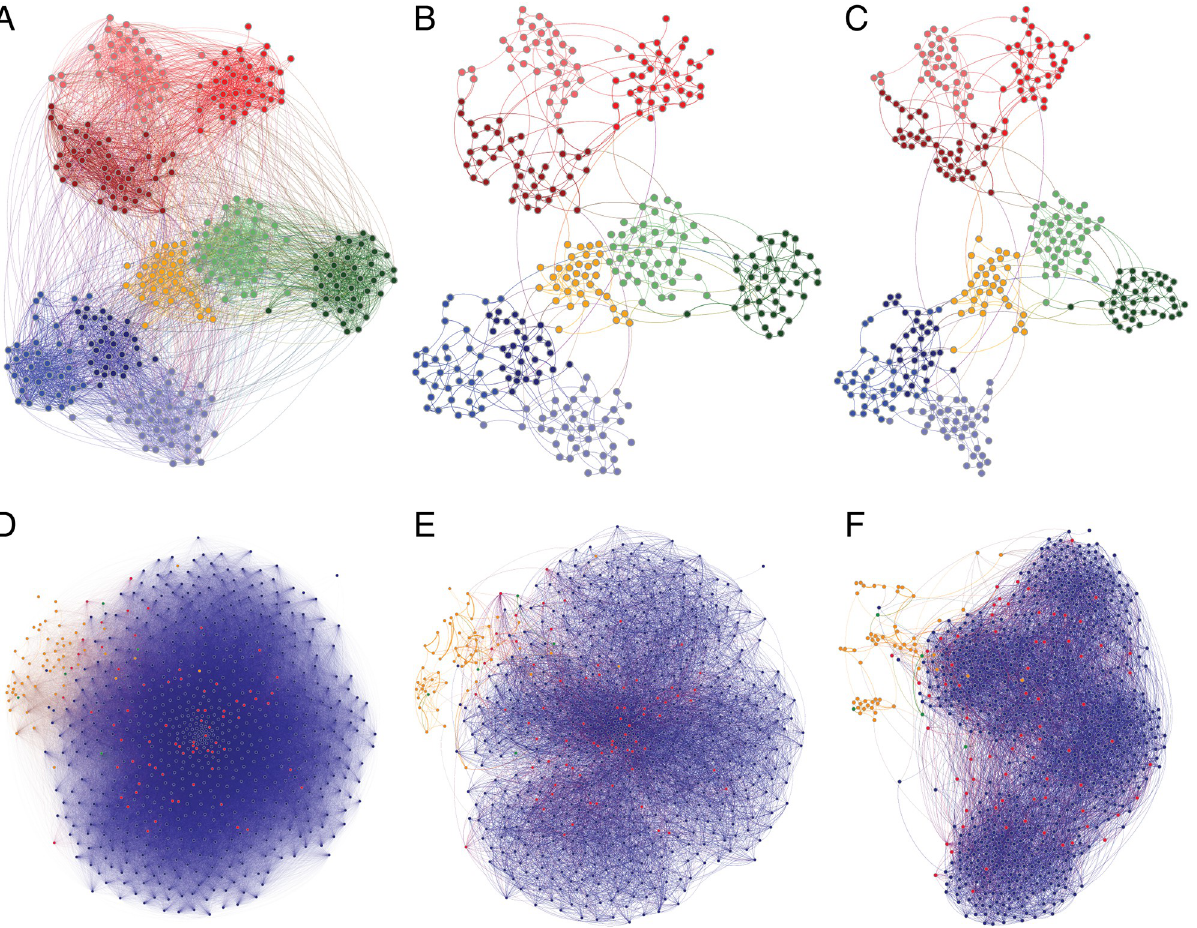
Fig 1. French high school (Fr-HS) and American high school (US-HS) contact networks. ( A-C ) French high school (Fr-HS) contact network of | X | = 327 students. Colors represent the four student specializations: “MP” in blue, “PC” in green, “PSI” in orange, and “BIO” in red; lighter or darker colors separate the distinct classes within each specialization. ( D-F ) American high school (US-HS) contact network of | X | = 788 students, staff, and teachers. Colors represent students in blue, teachers in red, and staff in orange. Other (unspecified) individuals are shown in green. No student class metadata is available. ( A, D ) Original networks with node layout computed by ForceAtlas2 algorithm [47], using all proximity weights, P ( X ). ( B, E ) Metric backbone subgraphs rendered with the same node layout as in the respective networks in ( A ) and ( D ). ( C, F ) Metric backbone subgraphs with node layout recomputed by ForceAtlas2 using only backbone (proximity) weights. Plotted with Gephi [48].